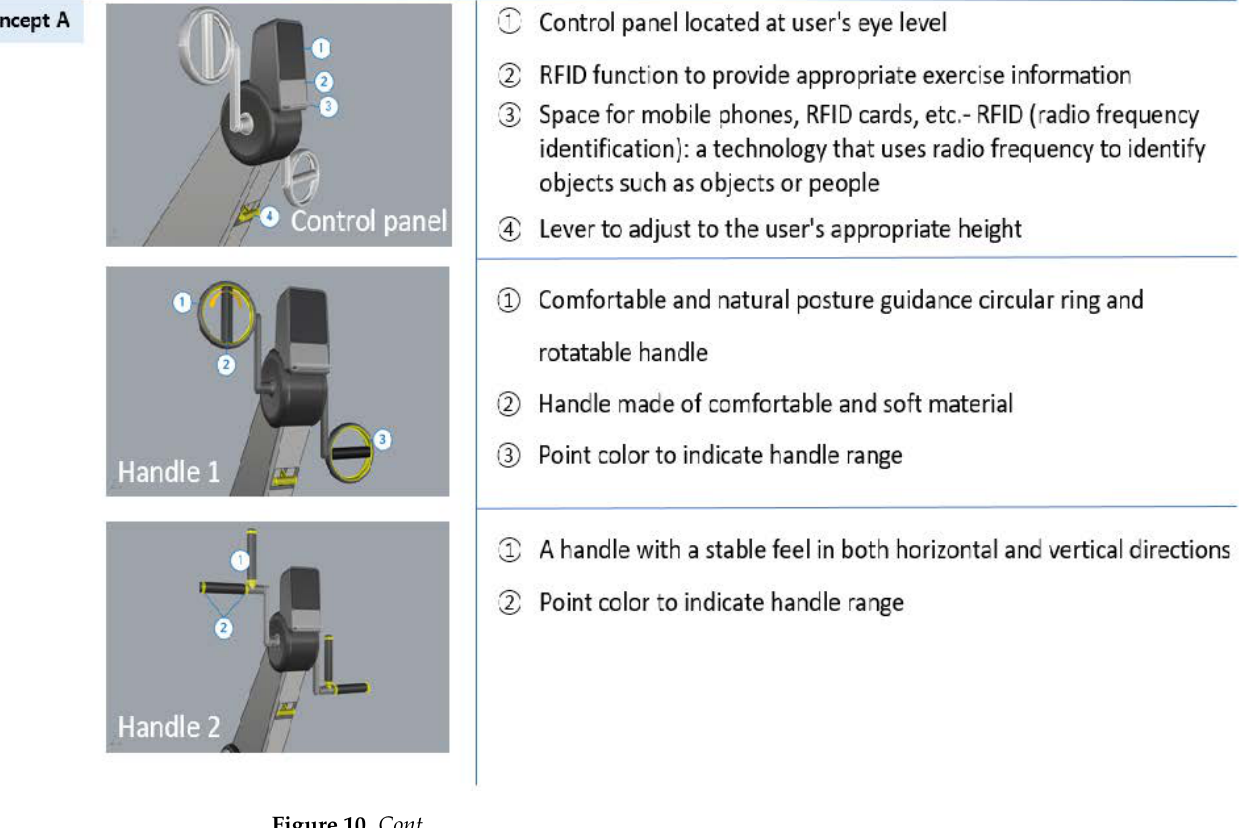
Figure 9. First 3D modeling of the treadmill design applying UD.